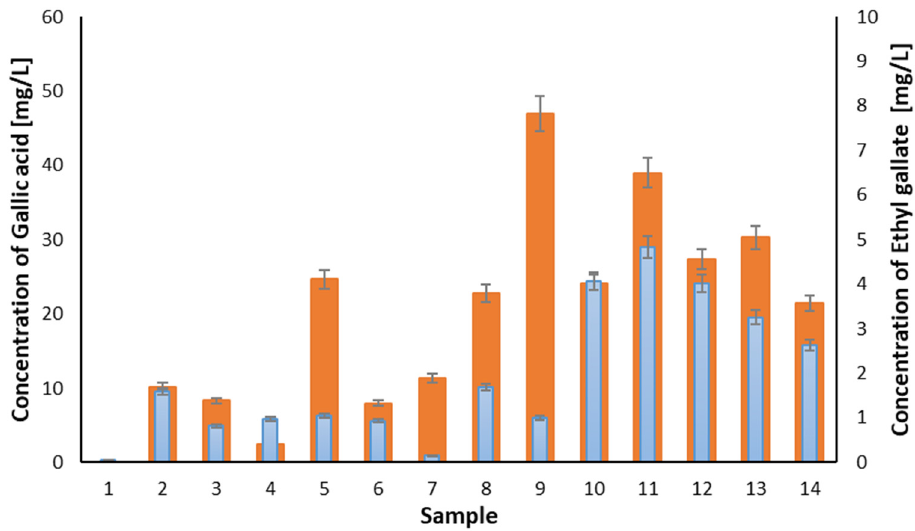
Figure 5. Comparison of the concentration levels of gallic acid (orange) and its ester ethyl gallate (blue) for set of samples of balsamic vinegars. Error bars represents standard deviation ( n = 3).